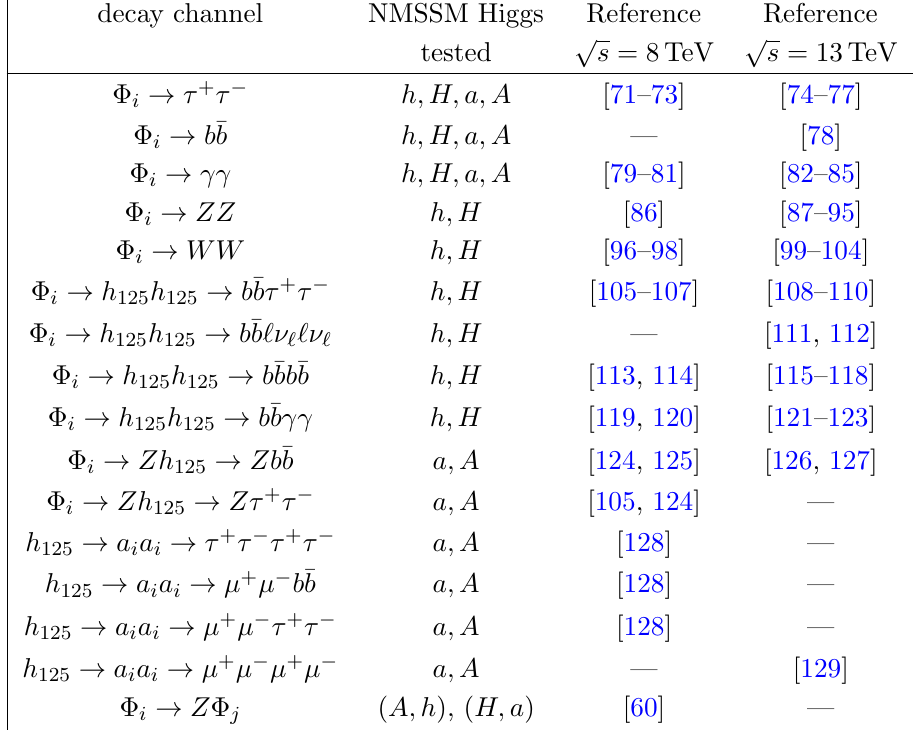
Table 2 . Direct Higgs searches at the LHC used for this work. The second column indicates the NMSSM Higgs bosons which can take the place of the generic scalar (cid:8) i in the (cid:12)rst column, recall that H=h ( A=a ) are the heavier/lighter non SM-like CP-even (CP-odd) states and h 125 is the observed SM-like 125 GeV Higgs boson. In the last row, the second column indicates possible pairs of ((cid:8) i ; (cid:8) j ) in the corresponding process in the (cid:12)rst